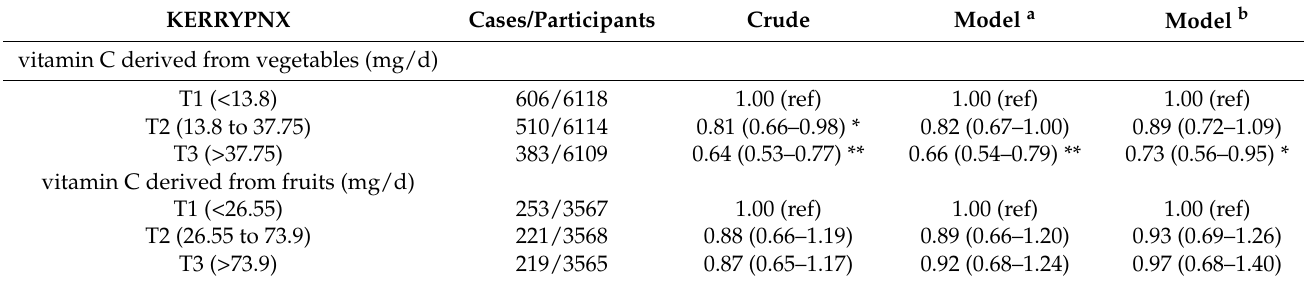
Figure 2. The results of dose response between dietary vitamin C intake and depressive symptoms. 3.3. Relationships between Dietary Vitamin C Intake Derived from Different Sources (Vegetables, Fruits), Vitamin C Supplements, Total Vitamin C Intake (Food + Supplements), and the Risk of Depressive Symptoms The association of dietary vitamin C intake derived from vegetables and fruits with depressive symptoms risk is shown in Table 5. In a multiple-adjusted model, compared with T1, the OR (95% confidence interval) of dietary vitamin C intake derived from vegetables T3 was 0.73 (0.56–0.95). The joint test of the effect for the multiple categorical variables was used, and the dietary vitamin C intake derived from vegetables was negatively correlated with depression, with an OR value of 0.996, p = 0.026. Table 5. Association between vitamin C intake derived from vegetables and fruits with depressive symptoms.